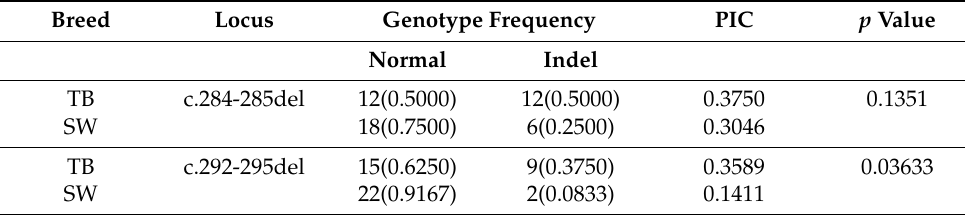
Table 2. Allelic and genotypic distribution of the MC1R gene in four rabbit breeds. Breed Locus